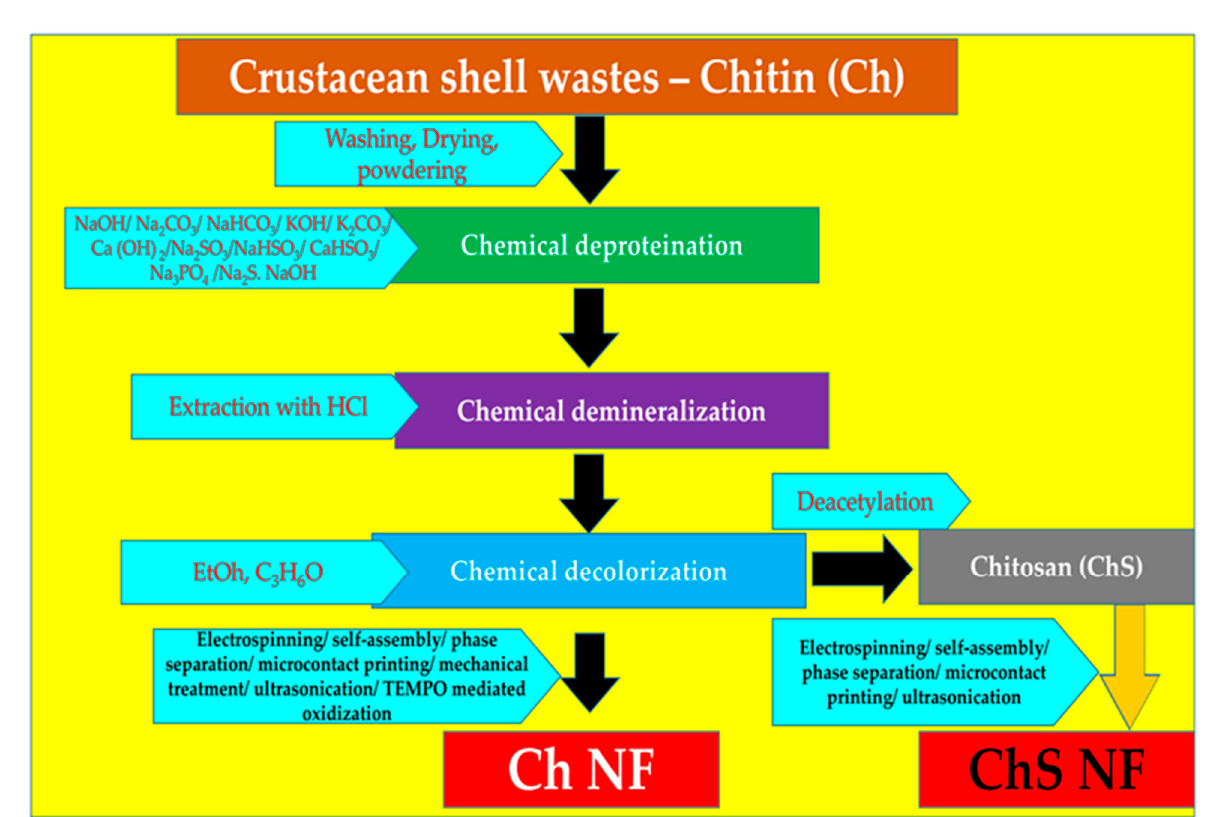
Figure 3. Overview of the overall steps involved in the fabrication of Ch/ChS